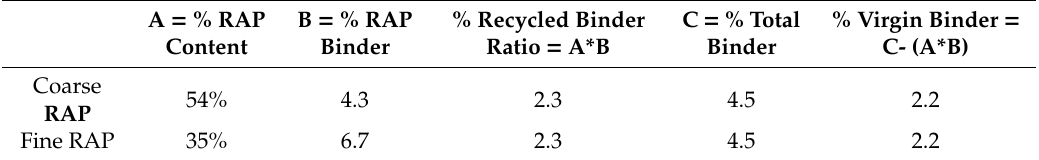
Table 1. Design criterion.